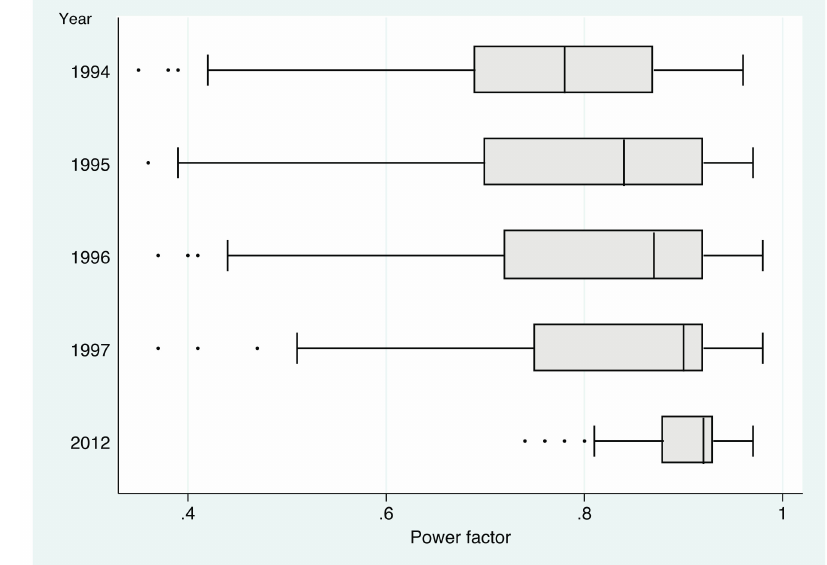
Figure 1. Box plot of power factor distribution over the sample period. A line in the middle of each box indicates the median of the sample in each year. The left and right edges of each box show the first and the third quartiles, respectively. Whiskers show the upper and lower adjacent values. The upper (or lower) adjacent value is the largest (or the smallest) observation that is within 1.5 times the interquartile range from each edge of the box. Dots are the units outside of the adjacent